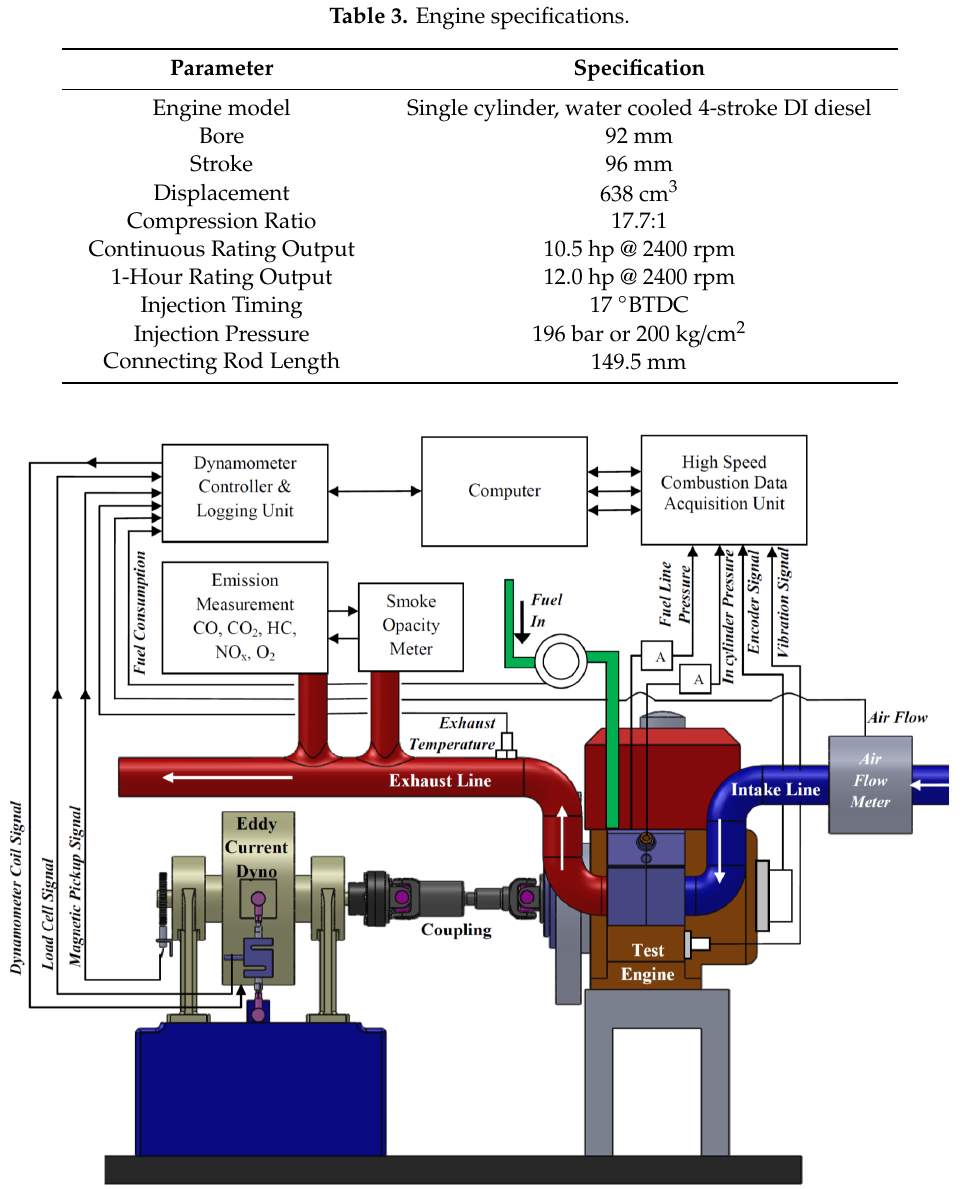
Table 3. Engine specifications.